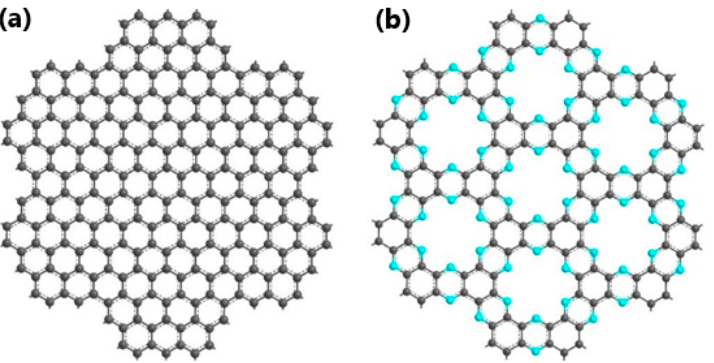
Figure 1. Comparison of the crystal structures of ( a ) graphene ( b ) C 2 N-h2D. Adapted and modified from [16].